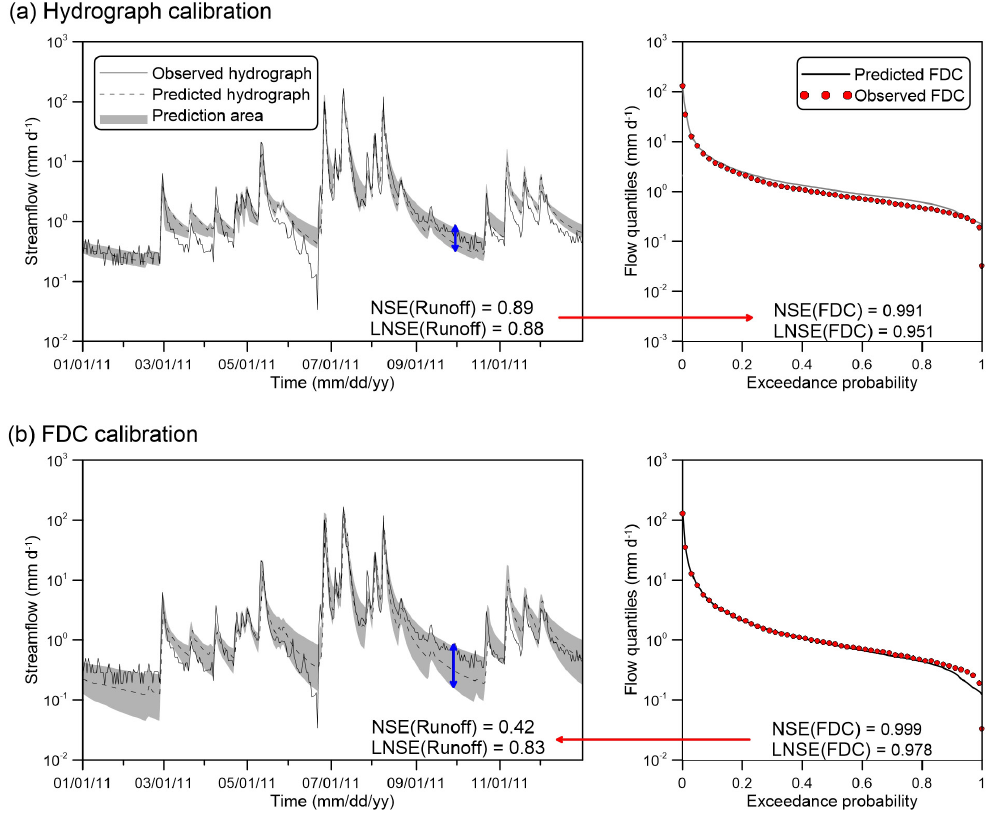
Figure 6. The observed and predicted hydrographs, the prediction areas, and the observed and predicted FDC given by (a) the hydrograph calibration and (b) the FDC calibration for Namgang Dam (Catchment 2 in Fig. 1).